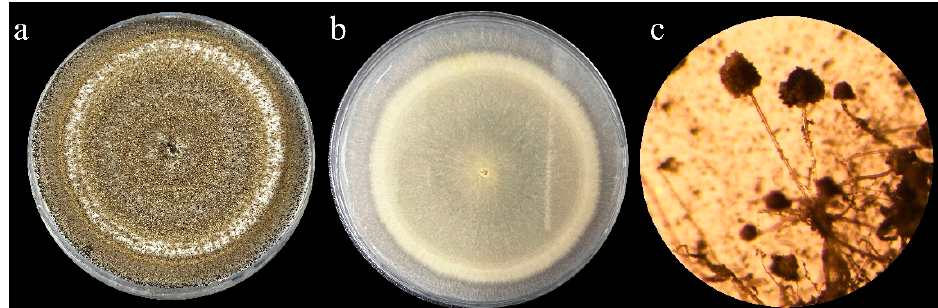
Figure 5. Colonial and conidial morphology of the isolate strain. ( a ) The front side of the colony; ( b ) the back side of the colony; and ( c ) conidial morphology.